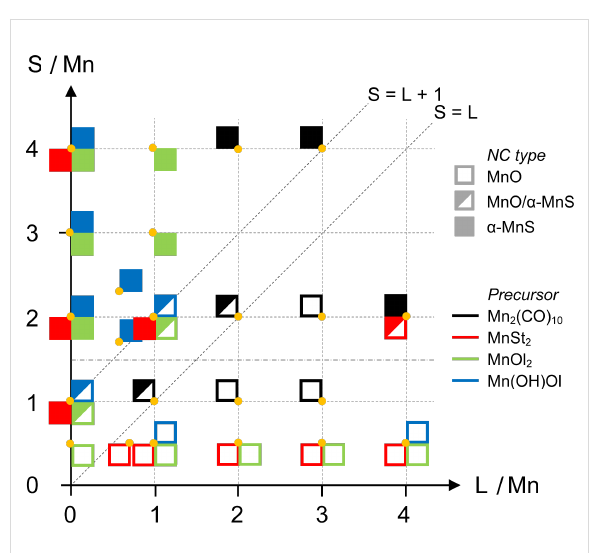
Figure 3: Pictorial representation of the NC outcome from the solvo- thermal synthesis involving the decomposition of different Mn precur- sors as a function of the L/Mn and S/Mn molar ratio. Each orange dot represents synthesis at the corresponding values of L/Mn and S/Mn. One to four squares arranged about each dot represent the resulting NCs when using different Mn precursors. The type of NC is encoded as follows: open squares: MnO NCs; half-filled squares: mixture of MnO and α -MnS NCs; solid squares: α -MnS NCs. The precursors are color coded as follows (counterclockwise from top left): black: Mn 2 (CO) 10 , red: MnSt 2 , green: MnOl 2 , blue: Mn(OH)Ol. The free surfactant, L, was StAc for Mn 2 (CO) 10 and MnSt 2 , and OlAc for Mn(OH)Ol and MnOl 2 ,